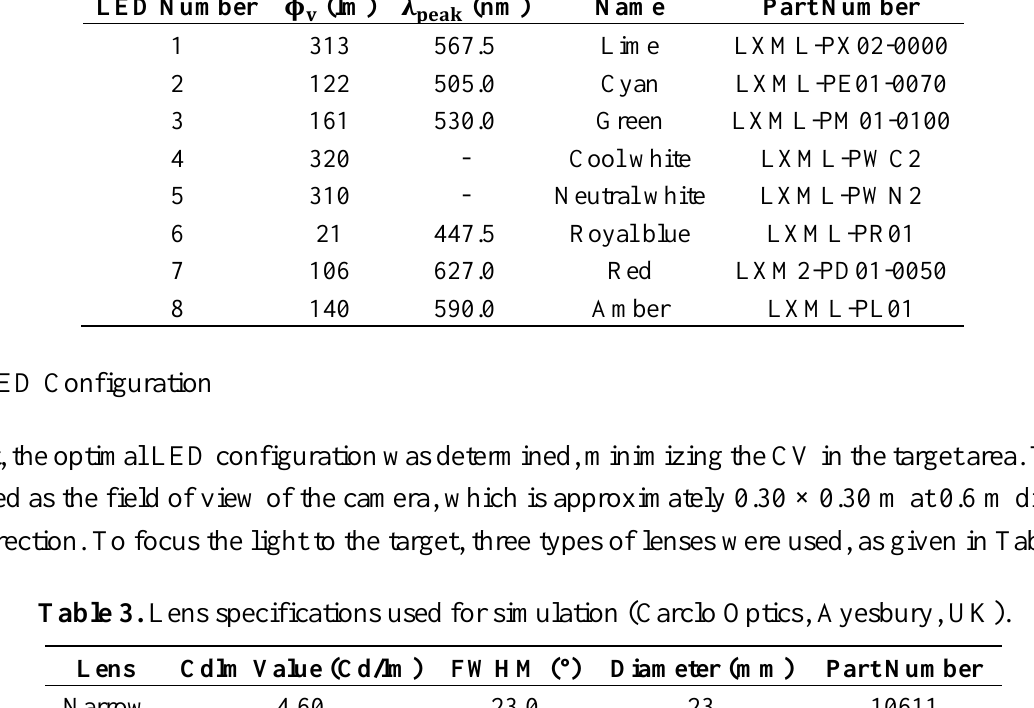
and the wavelength at peak intensity λ 𝑣